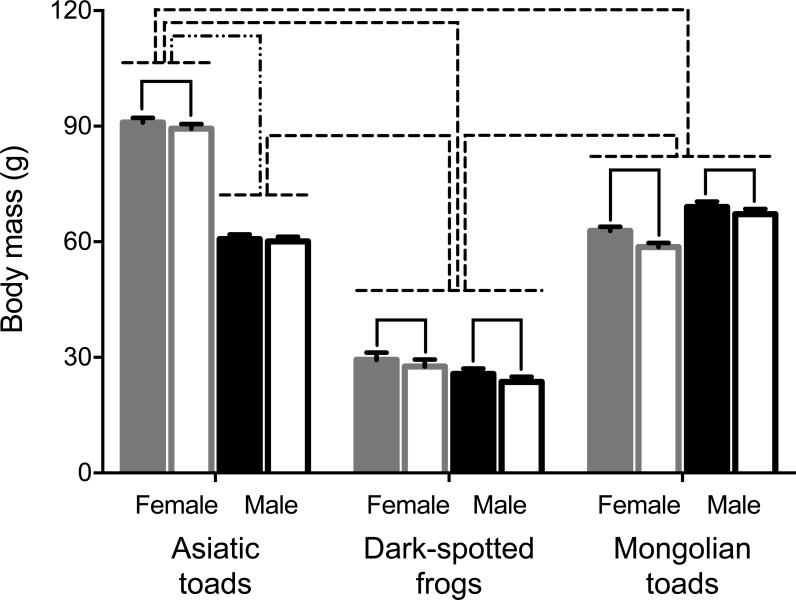
Effects of the phytohemagglutinin (PHA) assay, sex and taxa on body mass in the three anuran species studied: Asiatic toads, Dark-spotted frogs and Mongolian toads.Bars represent mean body mass ± 1 S.E.M. Body masses of female and male individuals of each species before the PHA injections are represented by solid gray and black bars respectively, and 72 h postinjection body masses of females and males are represented by unfilled gray and black bars, respectively. Bars or groups of bars connected by either solid (pre vs. post PHA injection), dashed-double-dot (sex) or dashed (species) lines indicate significant differences of body masses by Tukey’s HSD test (P < 0.05).